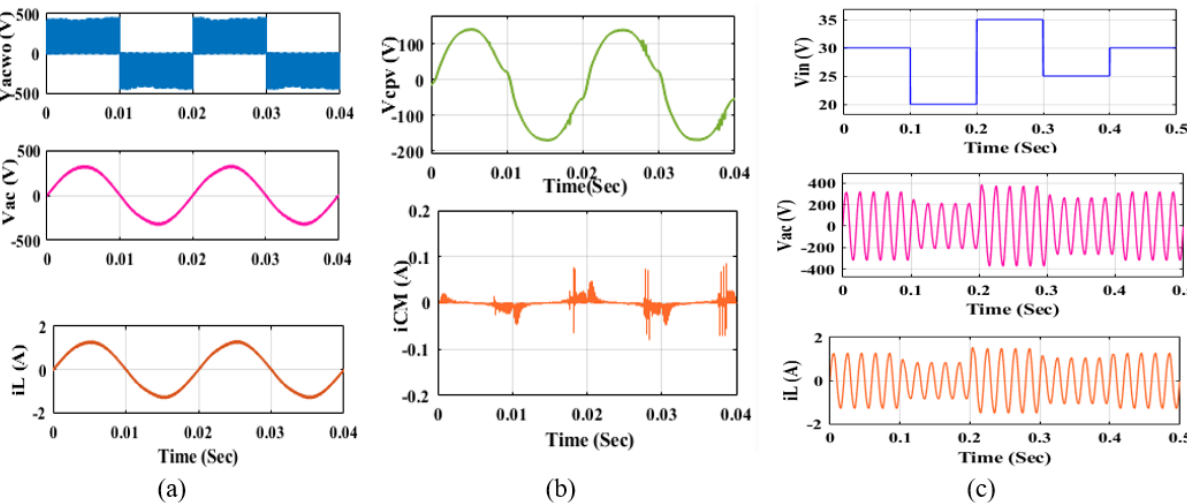
Fig. 5. (a) Voltage measured before filter (vacwo), Load voltage (vac) and Load current (iL) with 30V input. (b) Voltage across PV panel capacitance (vcpv) and CMLC (iCM) with 30V input (c) Load voltage and current with varying input voltage under standalone